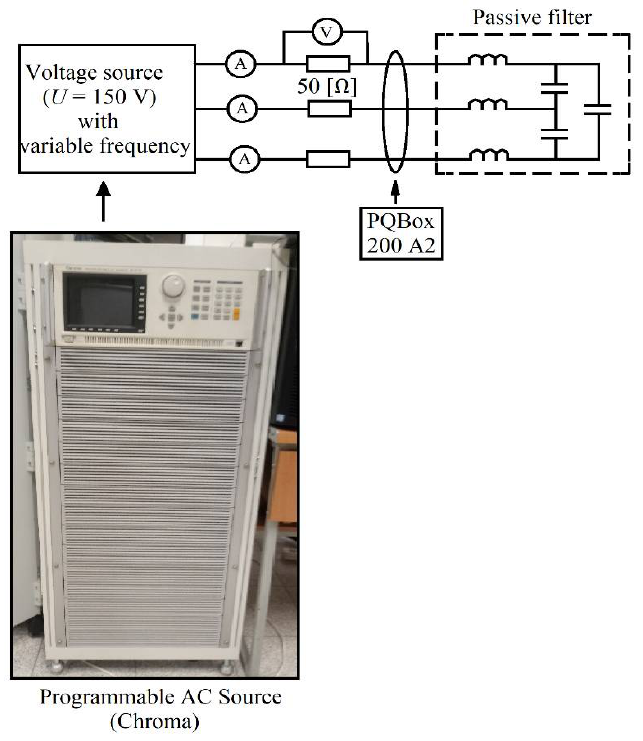
Figure 14. Equivalent electrical circuit used to measure the single-tuned filter impedance versus frequency characteristics (Chroma [66]). Table 4. Single-tuned filters resonance frequencies: the frequencies obtained from manufacturer data are compared to the frequencies obtained from the data in Table 3 and to the measured frequencies from the electrical circuit of Figure 14.